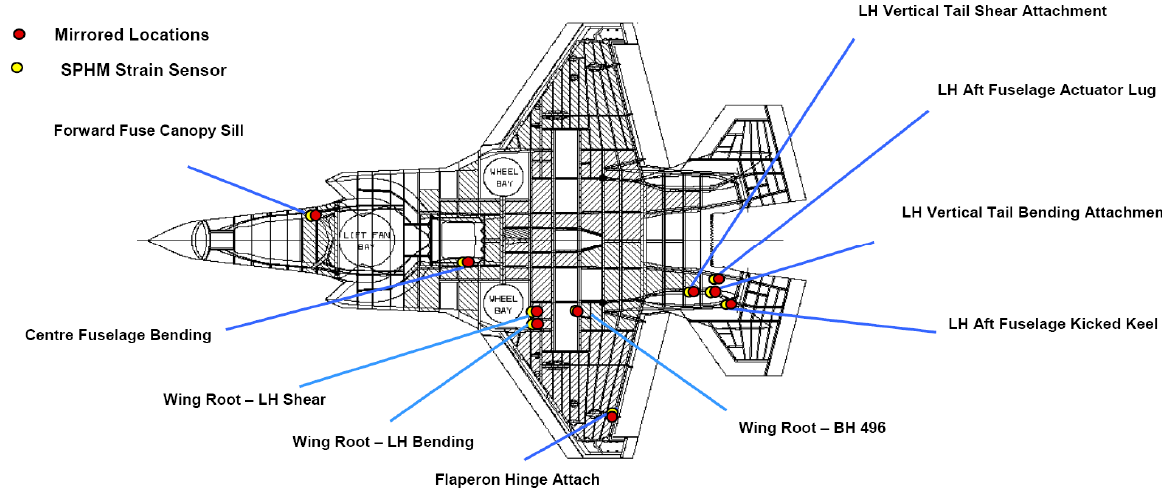
Figure 2. Strain gage location of F-35 [15].